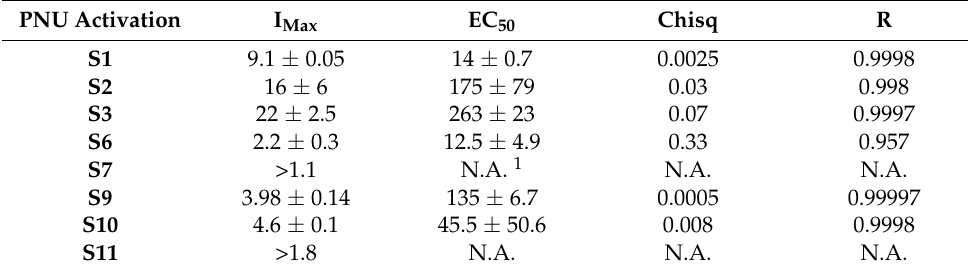
Figure 3. Responses of α 7 nAChR to sulfonium compounds coapplied with PAMs. ( A ) Potentiation of α 7 responses with 30 µ M racemic TQS. Shown are the average net-charge responses of seven or eight oocytes ± SEM. ( B ) Concentration- response studies of peak currents generated by compounds that gave positive responses with TQS, coapplied with 10 µ M PNU-120596. Each point represents the average ( ± SEM) of at least four oocytes. See Table 1 for curve-fit values. Table 1. Parameters extracted from curve fits for Figure 3B 1